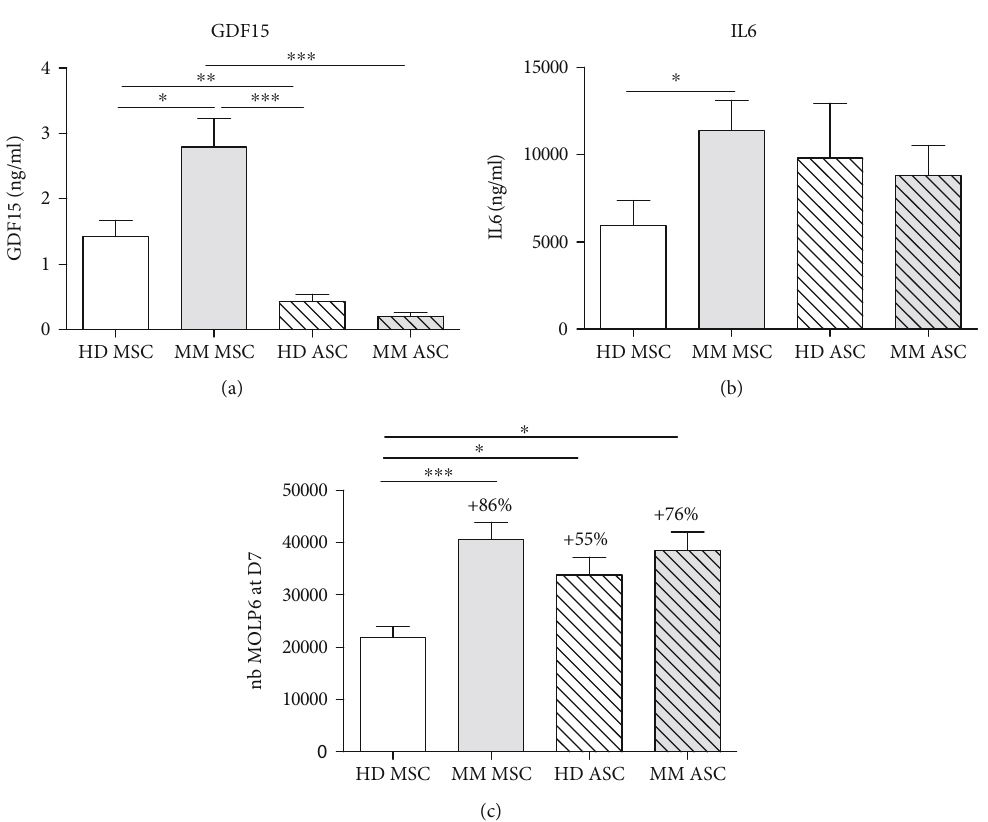
Figure 4: Comparison of promyeloma activities from HD and MM ASCs compared with autologous MSCs. (a) ELISA of GDF15 secretion from HD/MM MSCs and HD/MM ASCs. Data are the mean ± SEM ( n = 11 independent experiments). (b) ELISA of IL-6 secretion. Data are the mean ± SEM ( n = 9 independent experiments). (c) Number of MOLP6 MM cells on day 7 after coculture with HD/MM MSCs and HD/MM ASCs. Data are the mean ± SEM ( n = 9 independent experiments). Represents % increase compared to HD MSC condition. ∗ p < 0 : 05 , ∗∗ p < 0 : 01 , ∗∗∗ p < 0 : 001